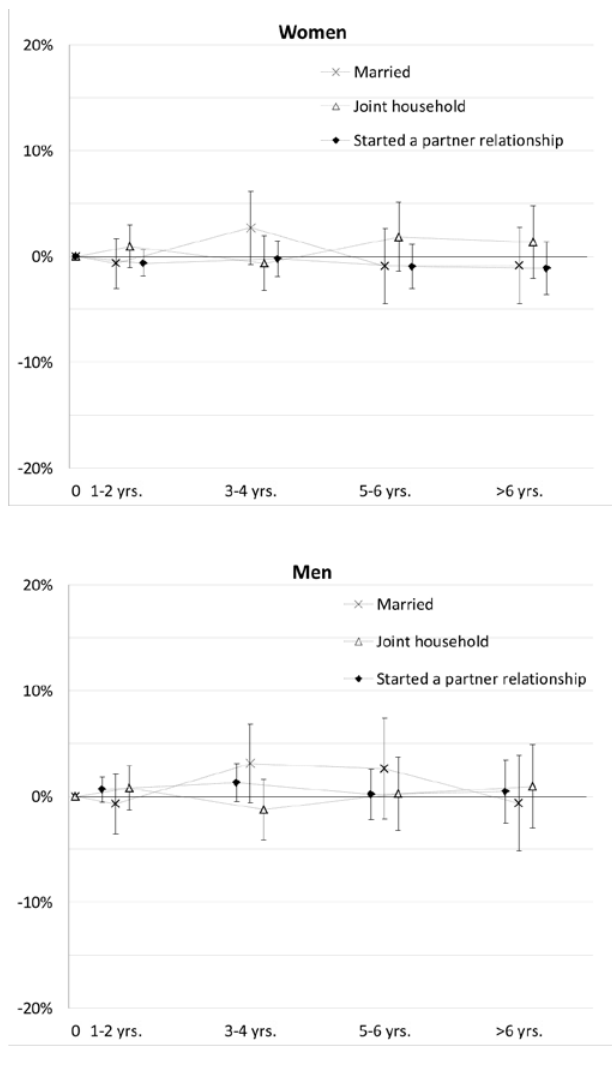
Figure 2 : Time-effects of partner relationships on social isolation (linear-probability models with fixed effects, percentage points and 95%-confidence limits)